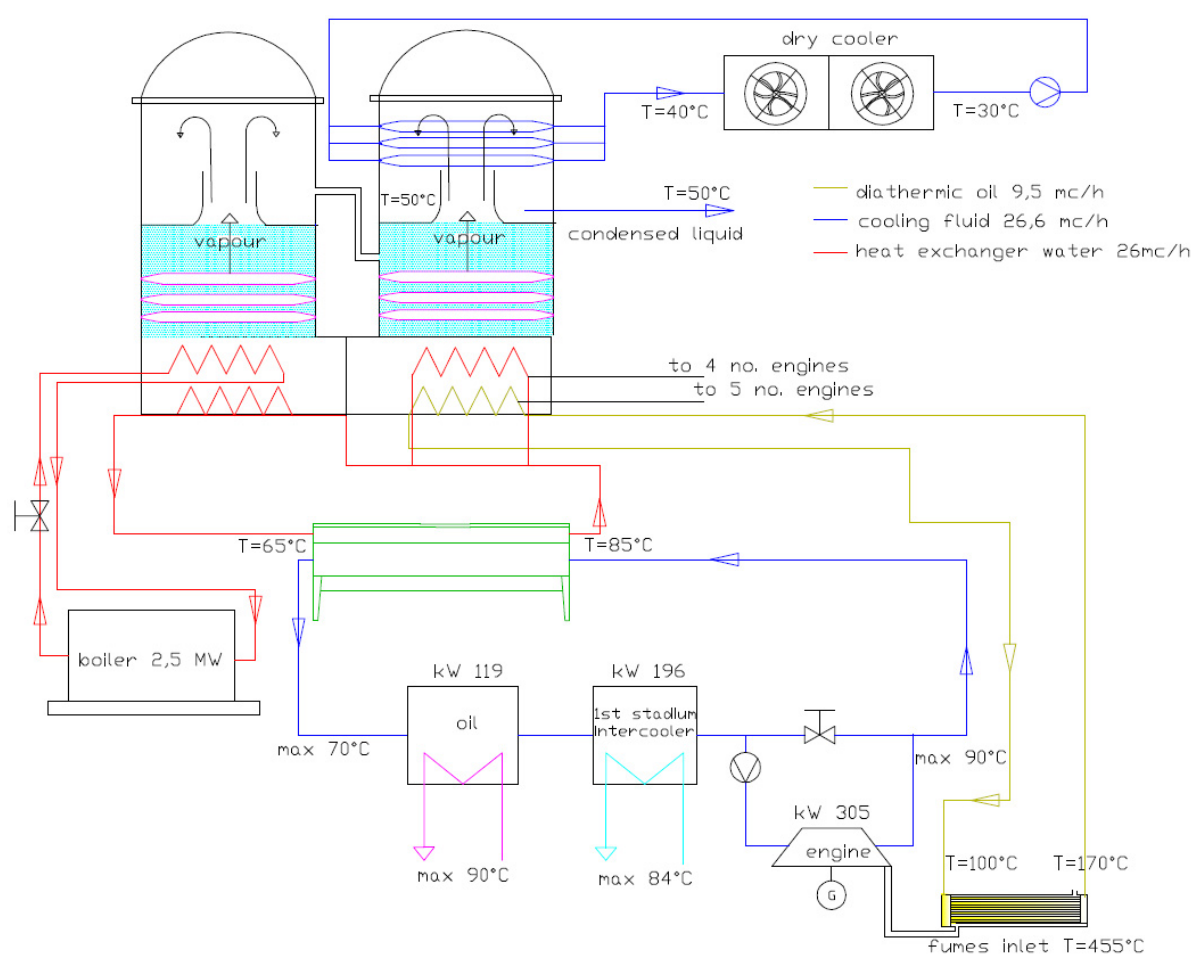
Figure 2. Unifilar diagram of the thermal power recovery plant in Scenario